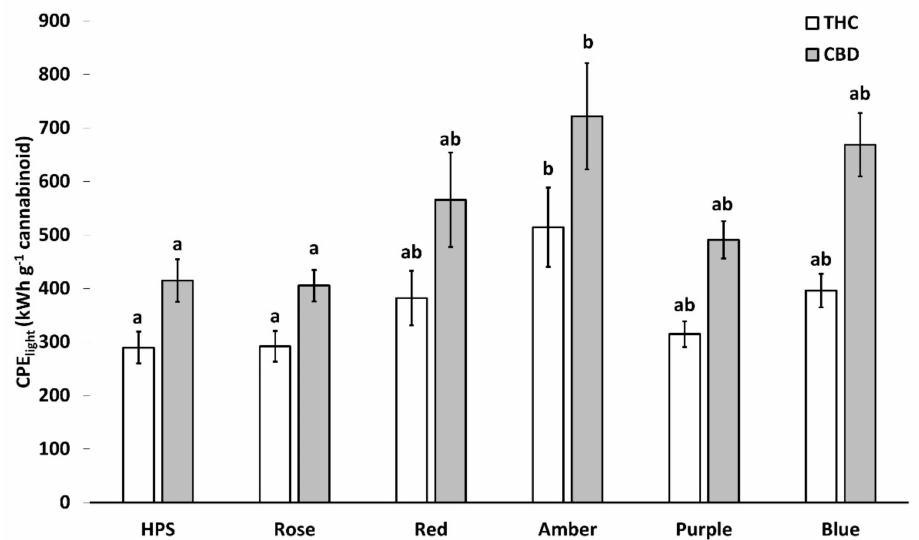
Figure 6. Effect of light treatment on light-associated cannabinoid production efficiency (CPE light ). Treatments are high-pressure sodium (HPS), blue (430 nm), red (630 nm), rose (430 + 630 nm, B:R ratio 1:10), purple (430 + 630 nm, B:R ratio 2:1), and amber (595 nm). Values presented in mean ± SE ( n = 3). Different letters (a, b) above the bars represent a significant difference between treatments by Tukey HSD ( p < 0.05). CPE ligt is given in kWh g − 1